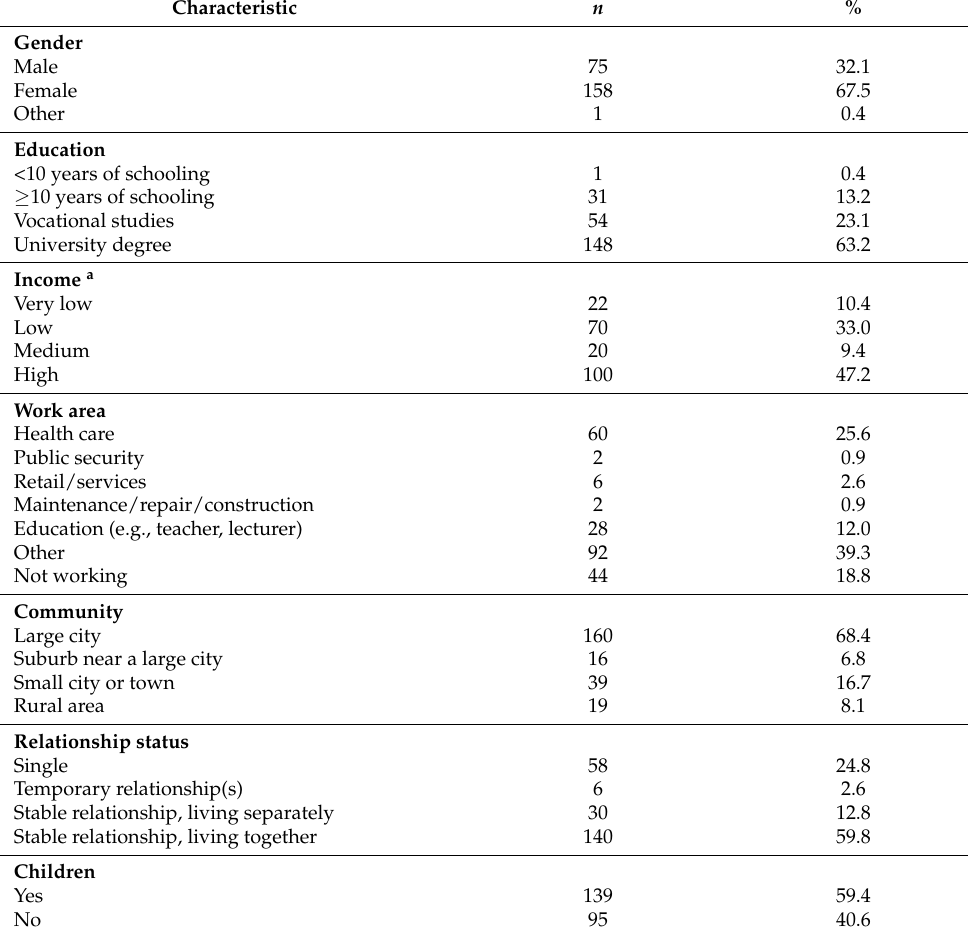
Table 3. Sociodemographic characteristics of the final sample ( N =